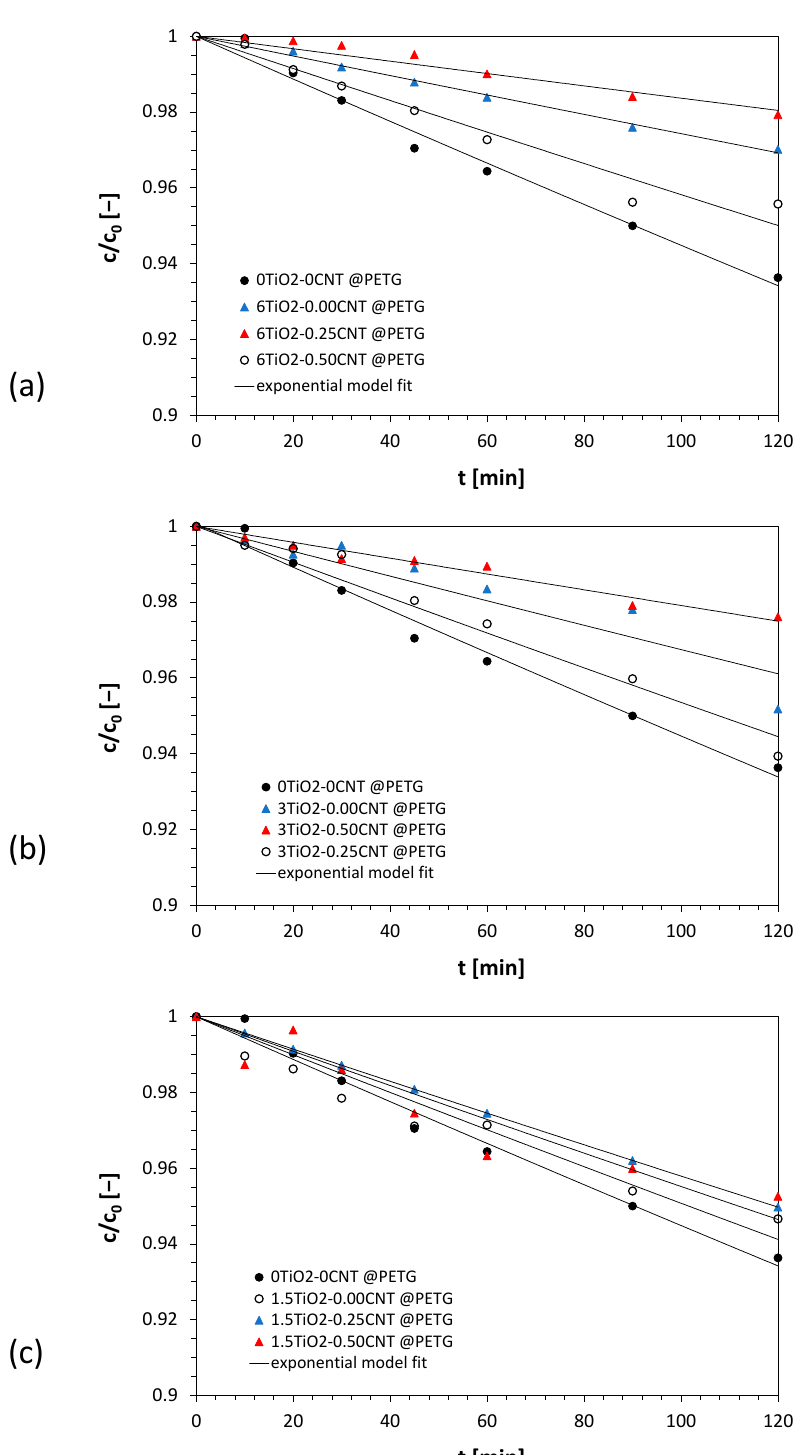
Figure 2. Comparison of observed amoxicillin decomposition trends with static mixers with different concentrations of TiO 2 and CNTs and reference mixer. Kinetics of amoxicillin decomposition using static mixer 6TiO 2 @PETG ( a ), 3TiO 2 @PETG ( b ) and 1.5TiO 2 @PETG ( c ).